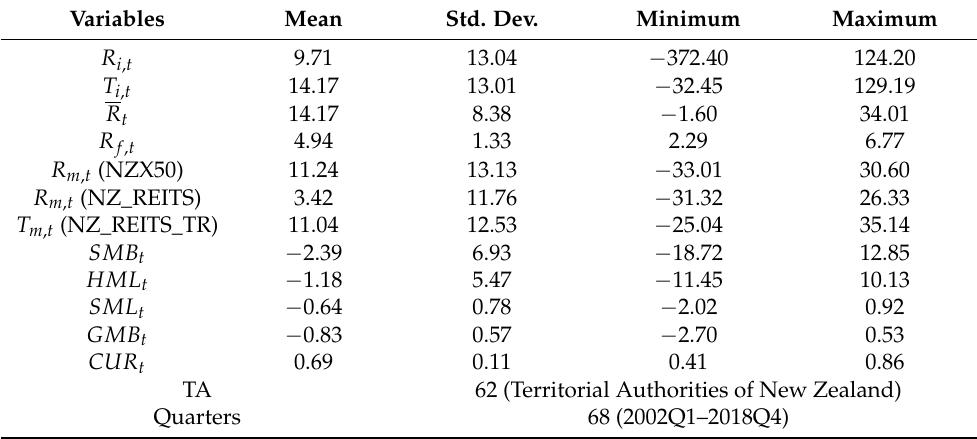
Table 3. Summary Statistics of the Panel